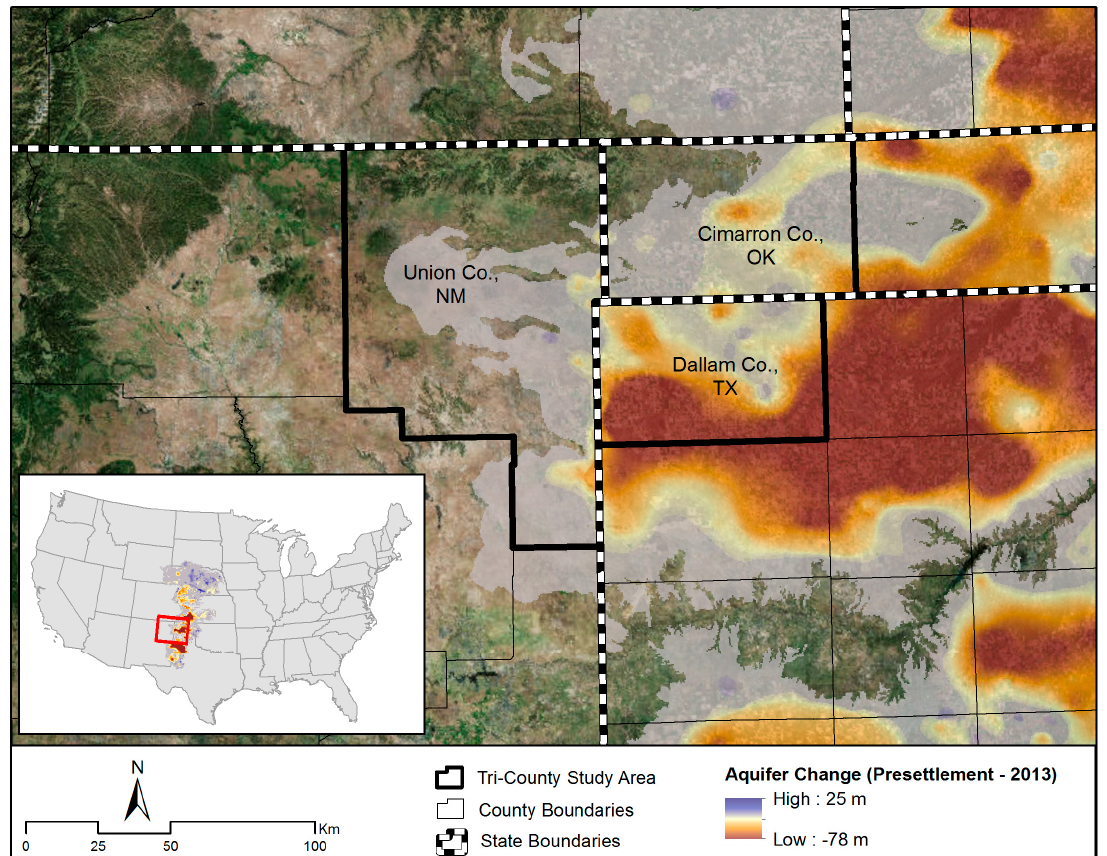
Figure 3. Study area counties within the tri-state region of the Southern High Plains. Source: Figure created by the authors using aquifer data from the U.S. Geological Survey.